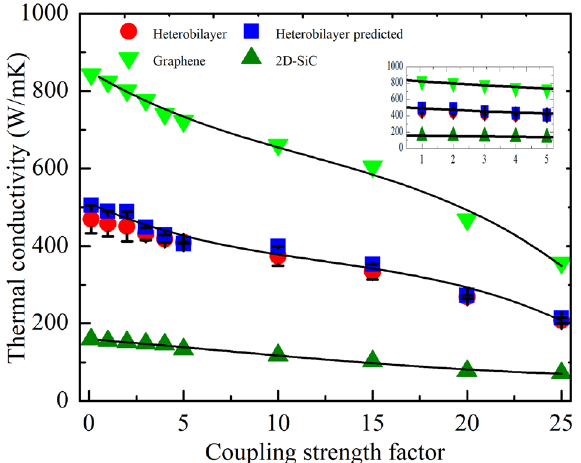
Figure 8. Dependence of in-plane thermal conductivity with interlayer coupling strength χ .